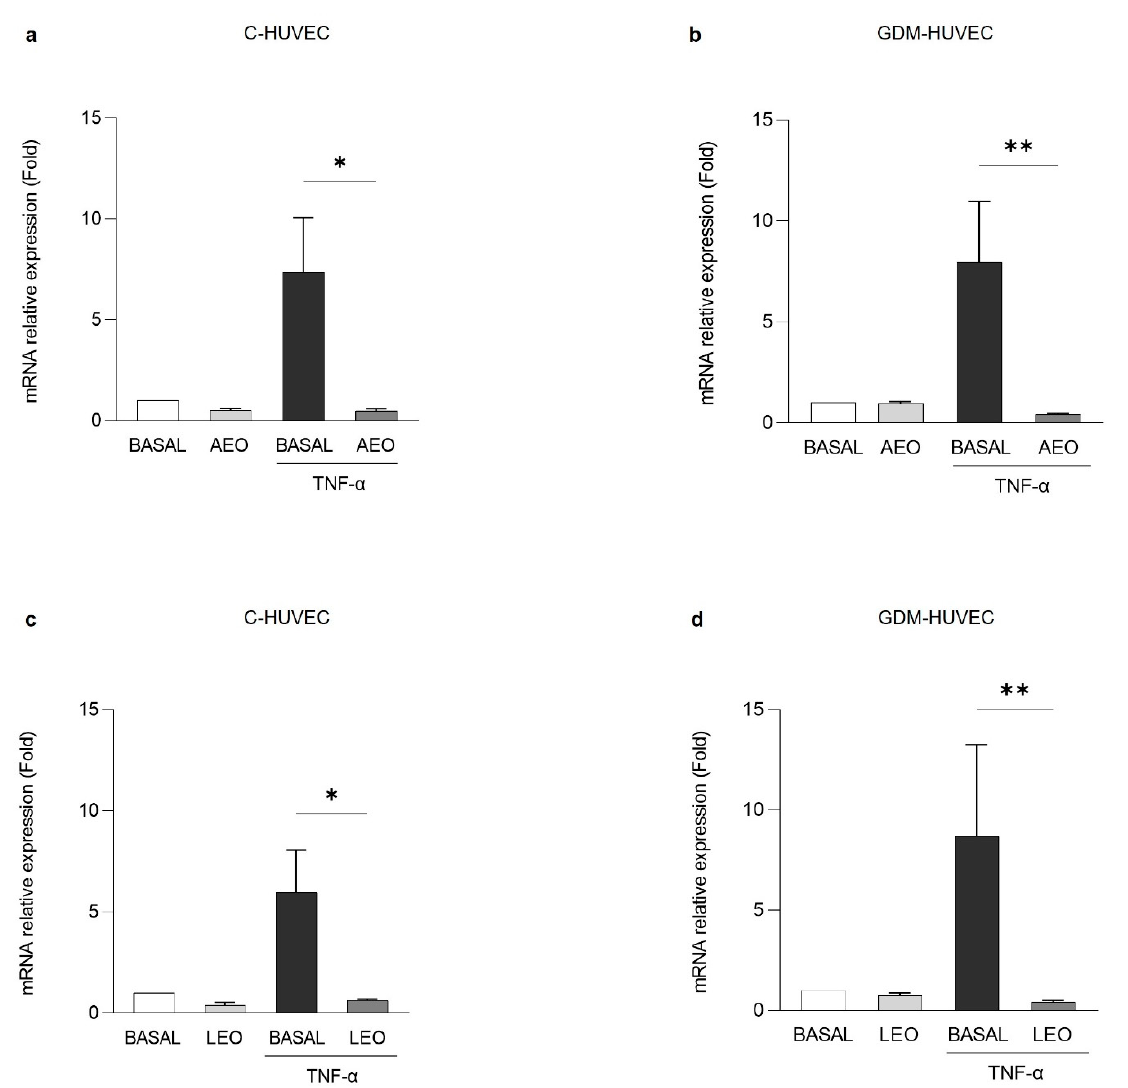
Figure 5. Effects of ( a , b ) AEO and ( c , d ) LEO on VCAM-1 mRNA expression in C- and GDM-HUVEC. Cells were serum-starved and incubated for 16 h with TNF- α (1 ng/mL), following 24 h of pre- incubation with AEO or LEO (0.025% v / v ) or with medium alone (BASAL). Results of RT-qPCR analysis are shown as individual values and mean ± SD of at least 3 independent experiments. ( a , c ) * p < 0.05 TNF- α vs. AEO+TNF- α or LEO+TNF- α ; ( b , d ) ** p < 0.01 TNF- α vs. AEO+TNF- α or LEO+TNF- α .